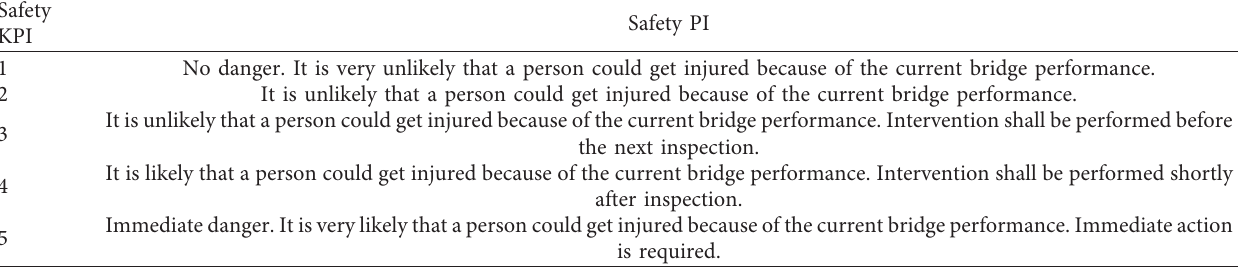
Table 3: Correlation between safety KPI qualitative scale and safety PI quantitative scale, adapted from [33]. Safety KPI